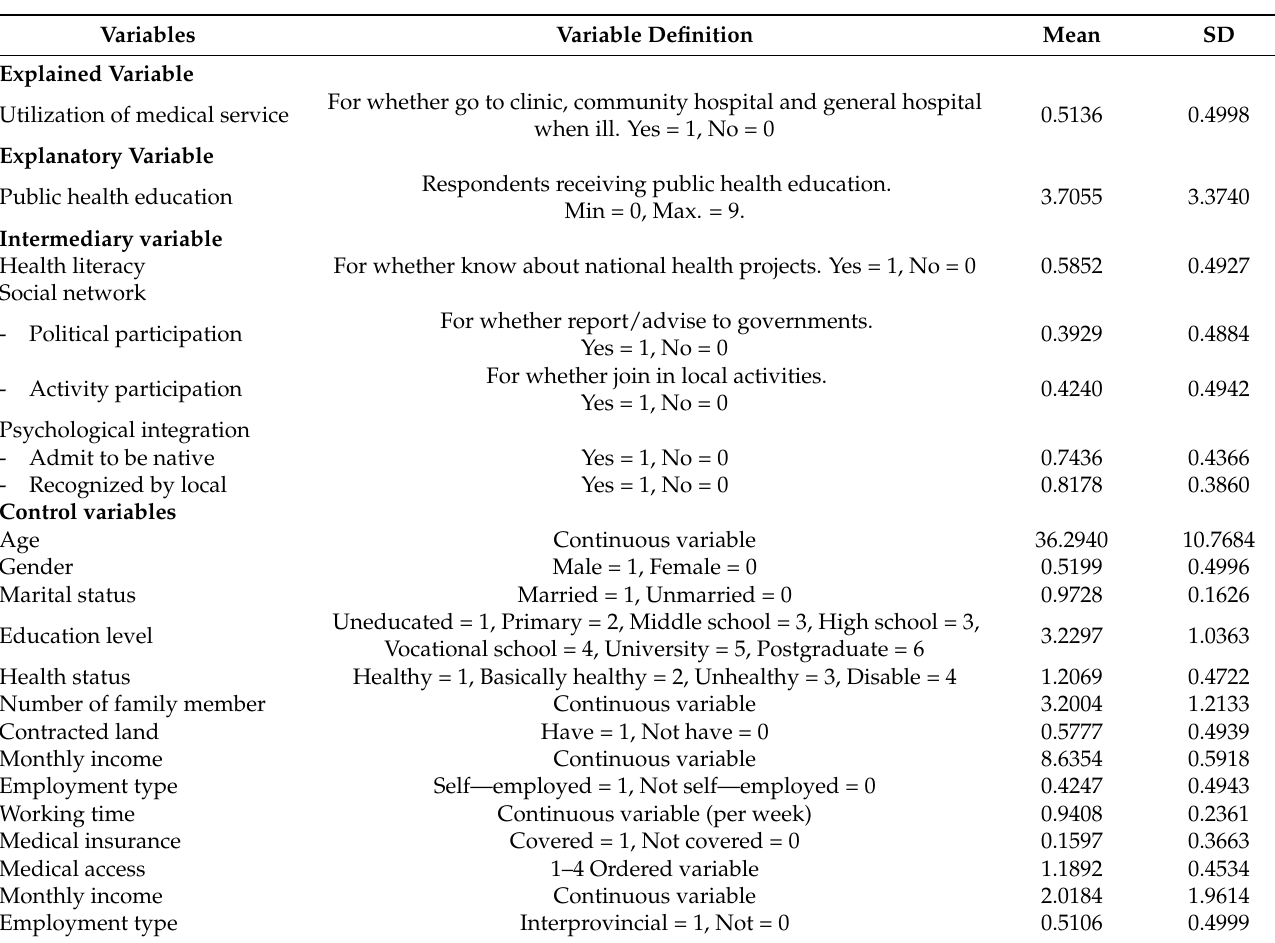
Table 1. Descriptive statistics of